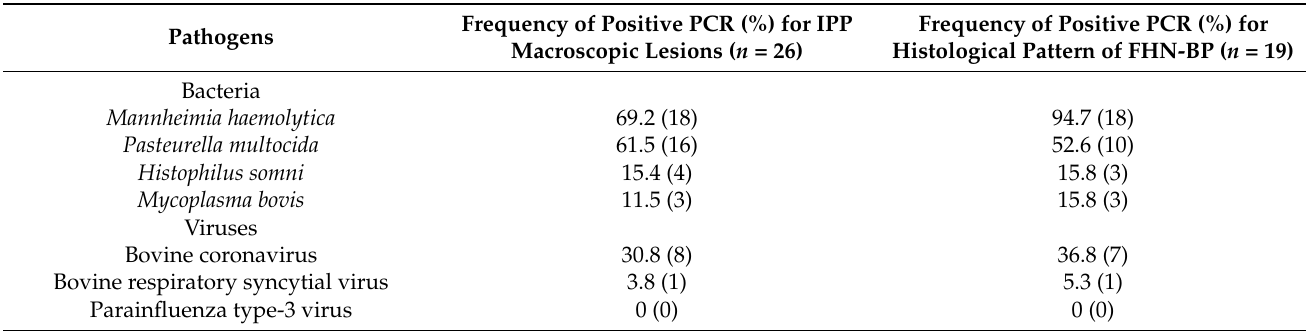
Table 3. Frequency of PCR-detected pathogens in the lungs of adult cattle with infectious primary pulmonary (IPP) macroscopic lesions and with histological pattern of fibrinous, hemorrhagic and/or necrotic bronchopneumonia (FHN BP).